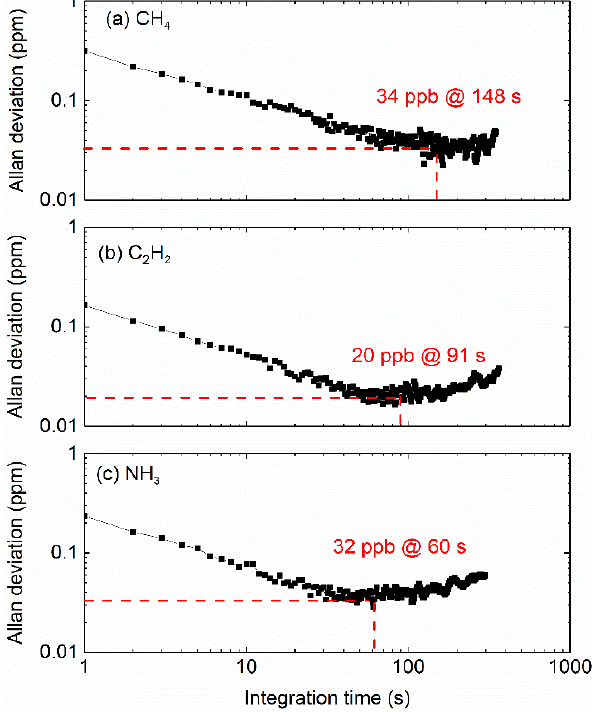
Figure 8. The Allan–Werle deviation curve of the current sensor for CH 4 ( a ), C 2 H 2 ( b ) and NH 3 ( c ).